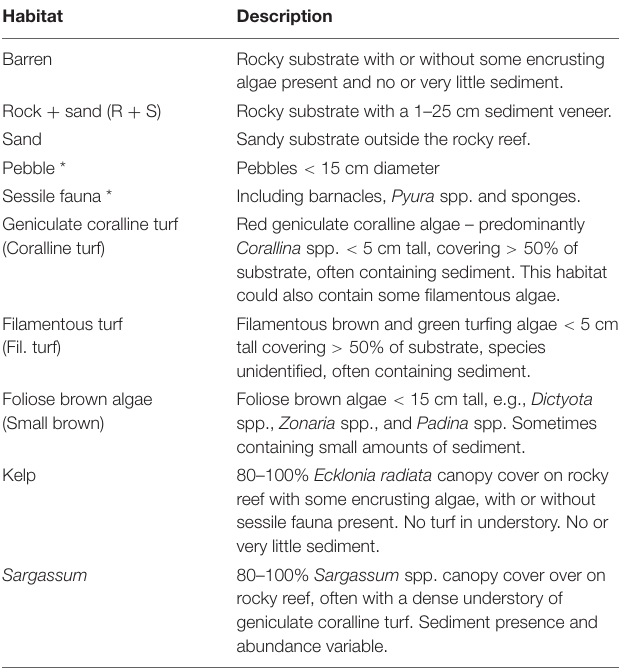
TABLE 1 | Recipient habitats investigated for C. filiformis recruit density. Habitat